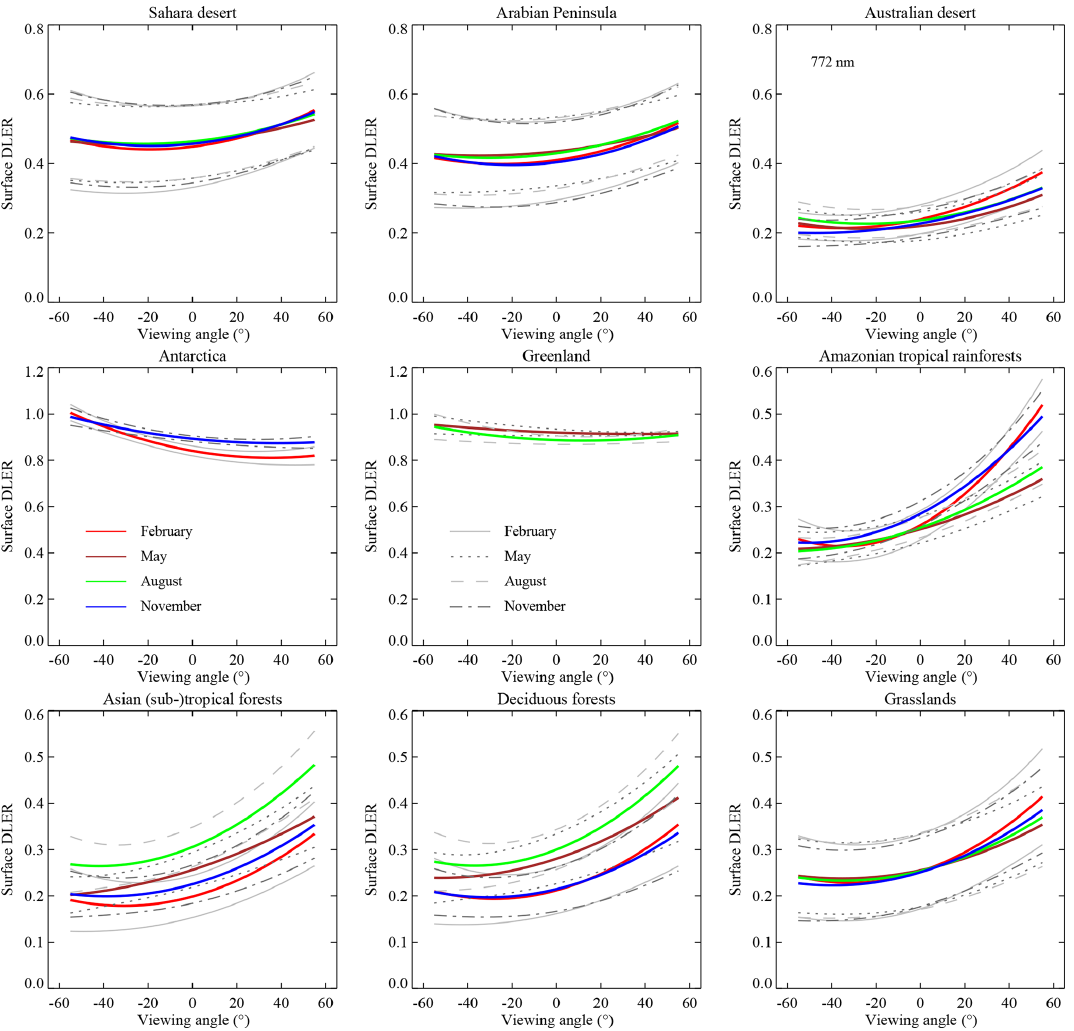
Figure 7. Surface DLER at 772nm versus viewing angle for nine surface types and four calendar months. The coloured curves represent the average GOME-2 surface DLER. The grey curves provide an indication of the spread in surface DLER over the selected